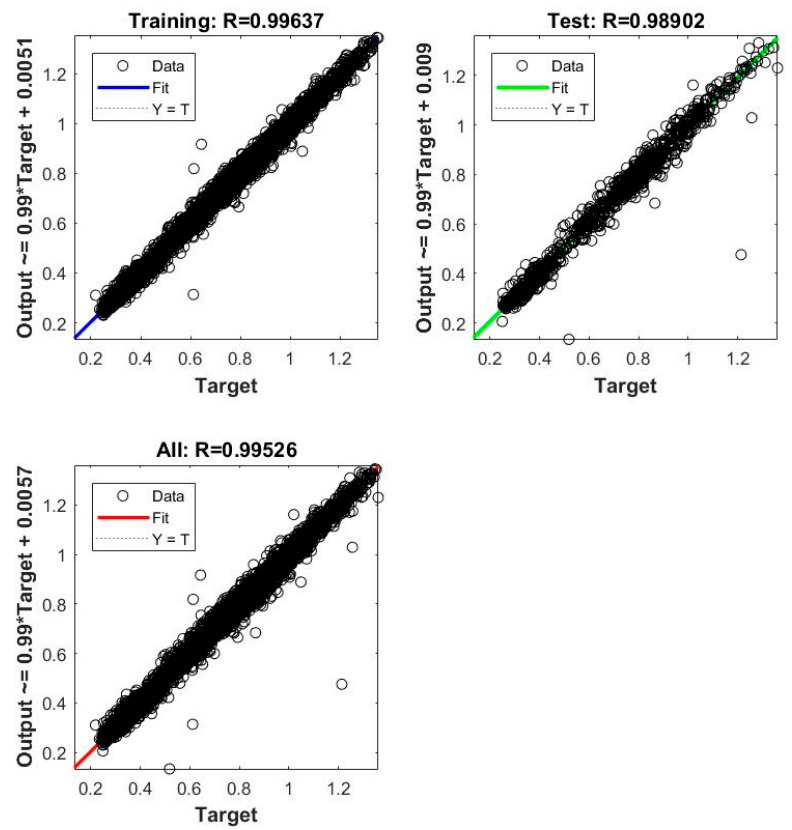
Figure 7. The regressions between the network targets and network outputs when forecasting the electricity consumption for the month of December, using the ANN_NAR_BR network.